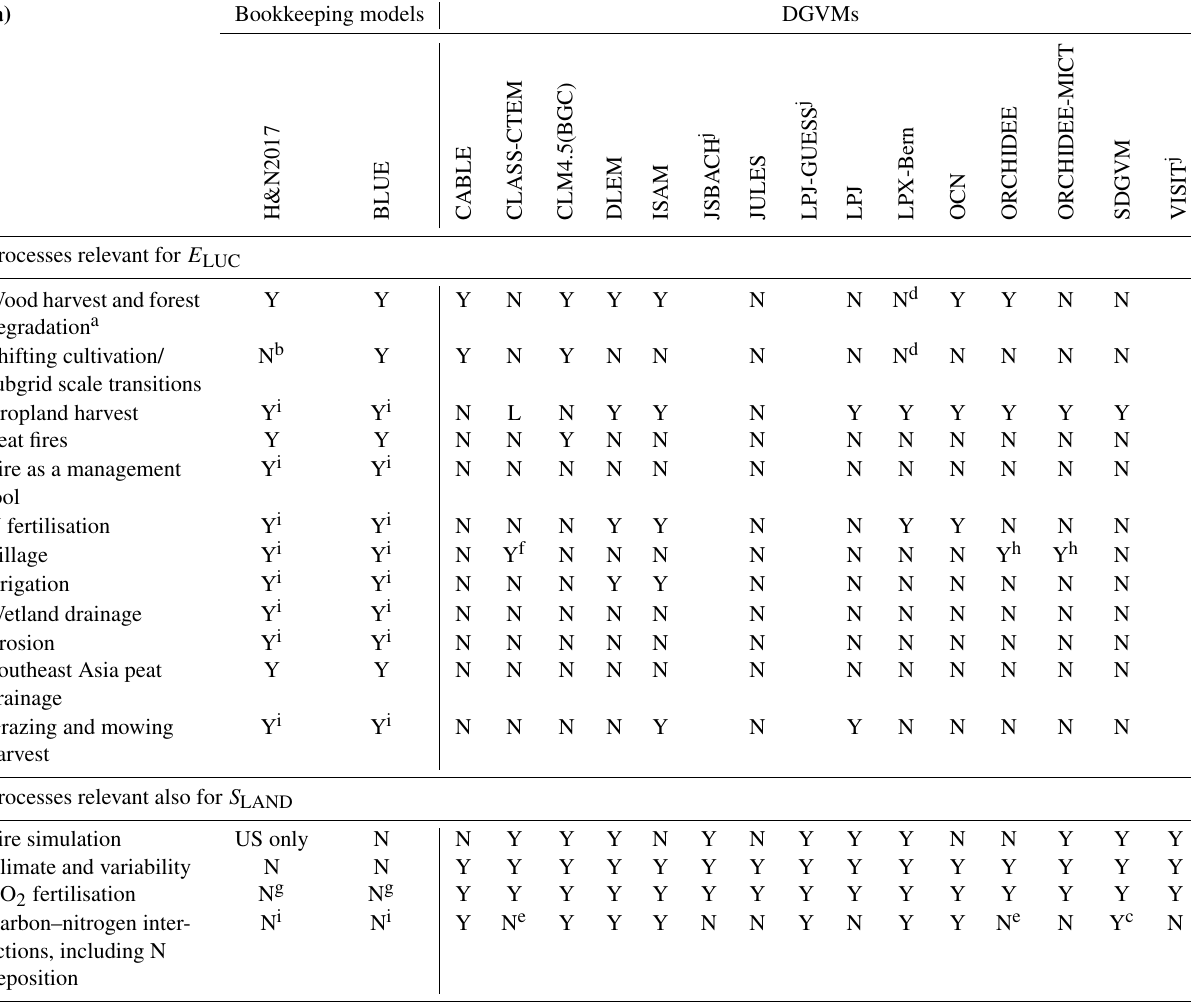
Table A1. Comparison of the processes included (Y) or not (N) in the bookkeeping and dynamic global vegetation models for their estimates of E LUC and S LAND . See Table 4 for model references. All models include deforestation and forest regrowth after abandonment of agriculture (or from afforestation activities on agricultural